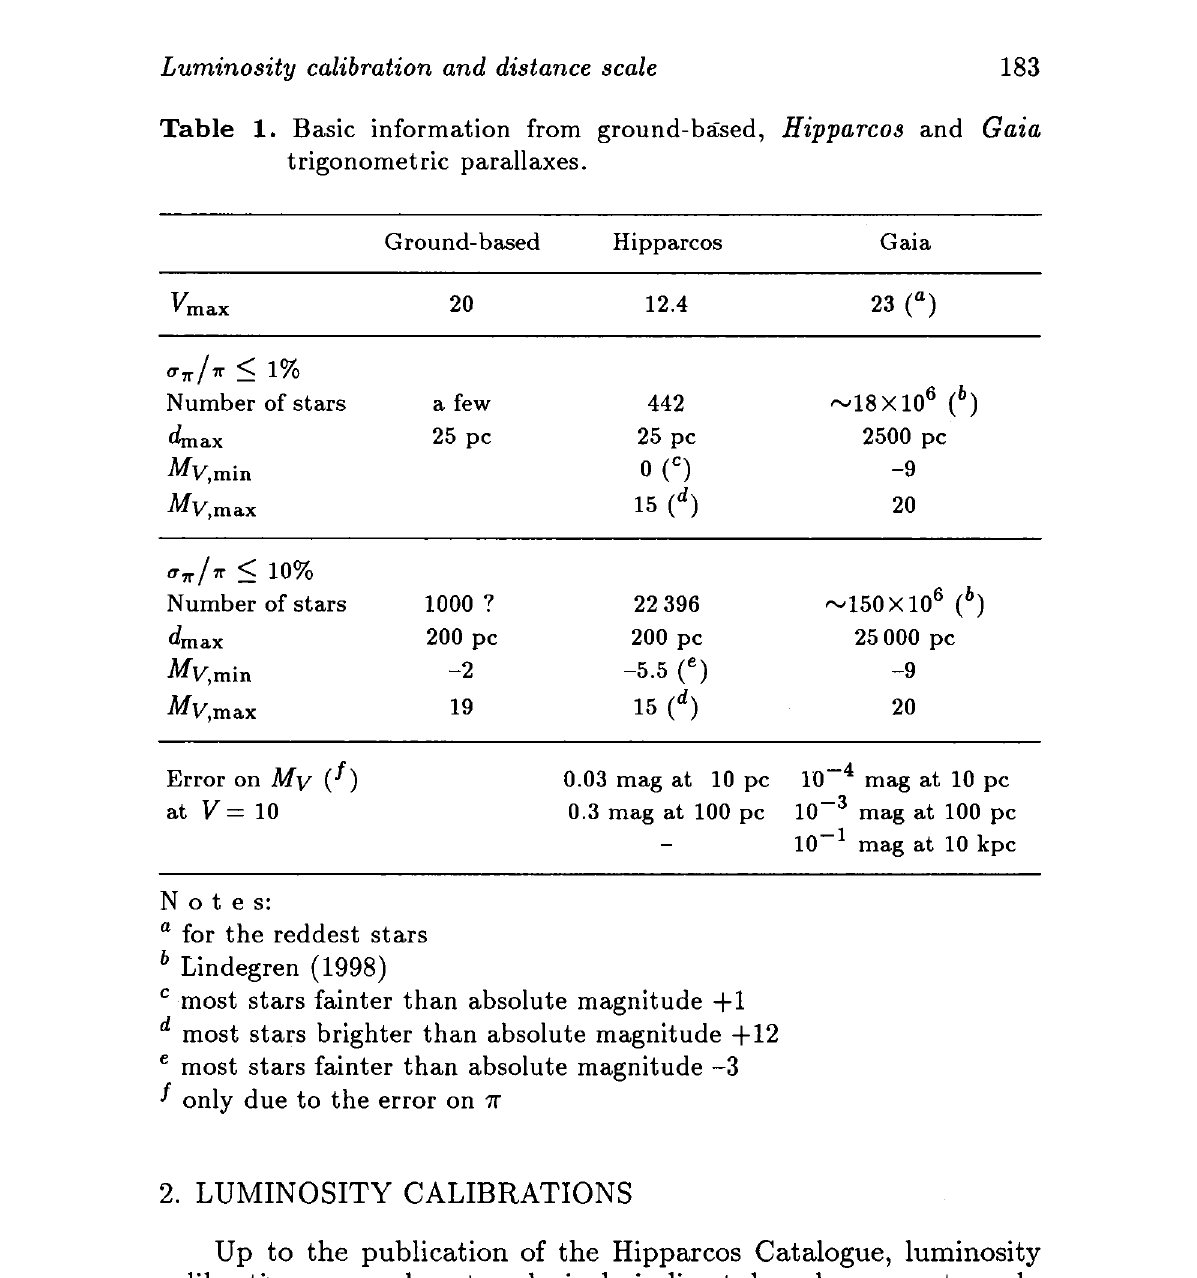
Table 1. Basic information from ground-based, Hipparcos and Gaia trigonometric